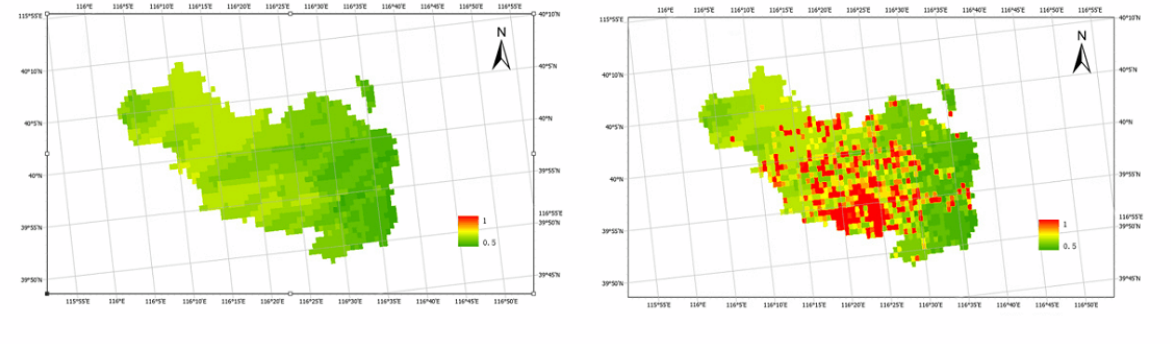
Figure 12. Ratios of days with estimates of PM 2.5 concentrations to total days in densely populated regions, before ( left ) and after ( right ) the introduction of smartphone photograph-based estimates of PM 2.5